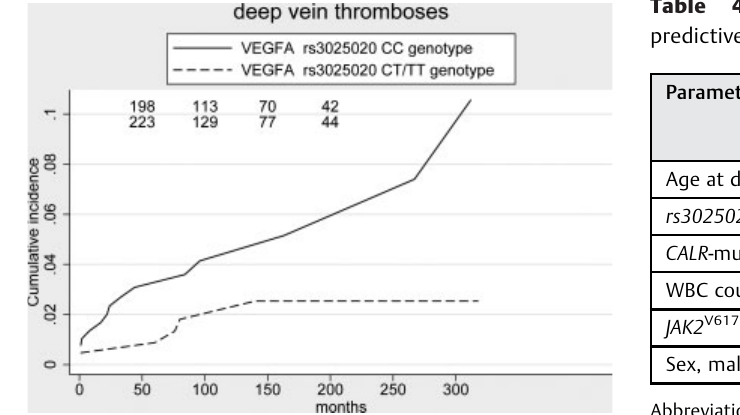
Fig. 1 Cumulative incidence of deep vein thrombosis in typical sites in 844 subjects with PMF strati fi ed for the rs3025020 VEGFA poly- morphism genotypes: subjects with CT/TT genotype had a signi fi cant lower risk of thrombosis ( p ¼